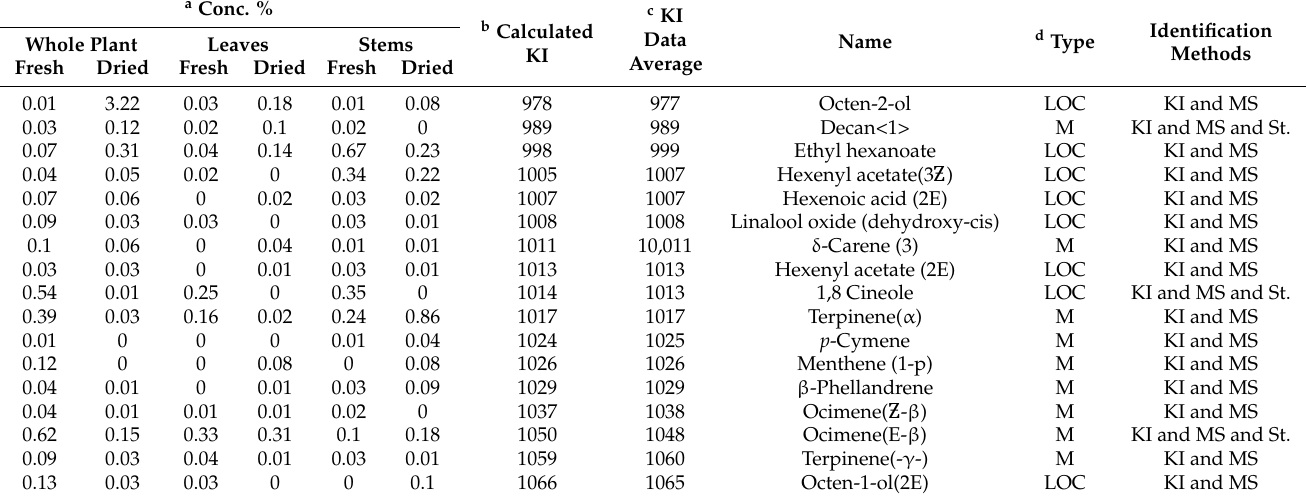
Table 1. Chemical components of volatile oils from fresh and dried Mentha suaveolens L. analyzed by GC/FID and GC/MS.